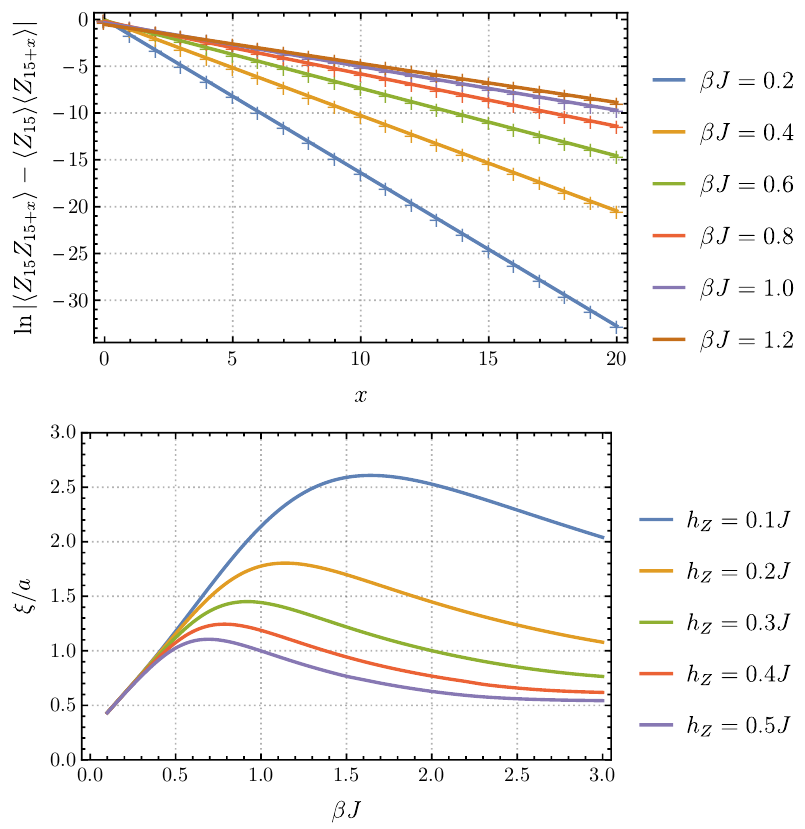
Figure 8: Lower plot: Correlation length ξ for different inverse temperatures β and = 1.05 J in (21) and a is the lattice spacing. Upper longitudinal fields h . N = 50, h Z X = 0.1 J . + are numerical data and lines plot: As an example, details of fitting at h Z are linear fitting.